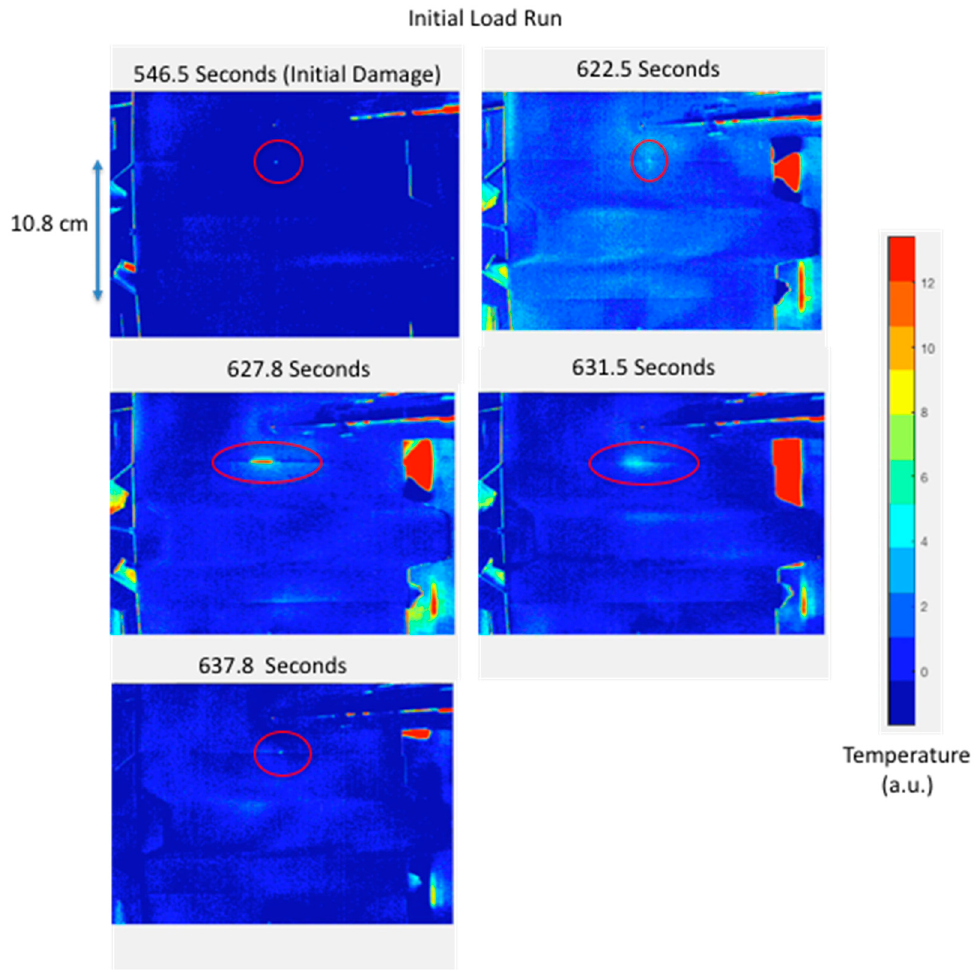
Figure 4. Processed thermal inspection images for a single quasi-static load run 1.